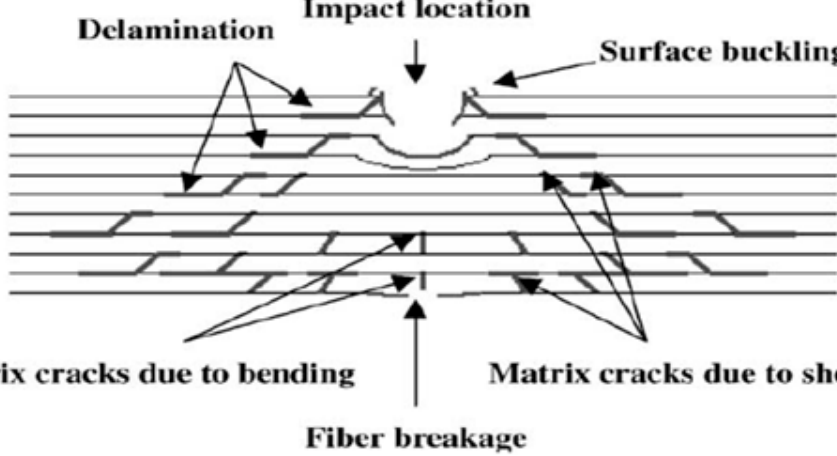
Figure 12. Schematic representation showing a typical impact damage mode for a composite laminate